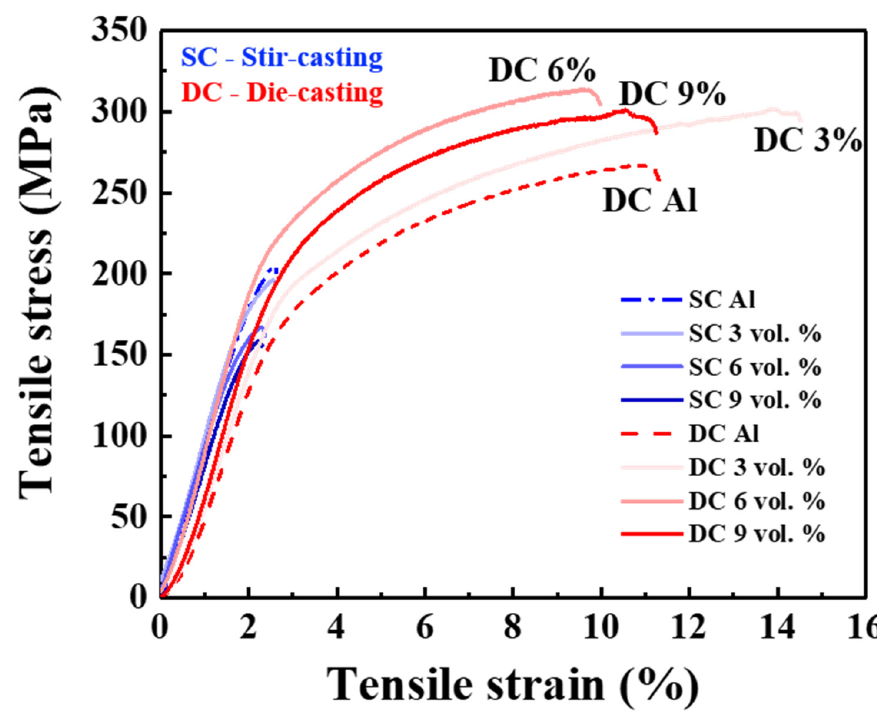
Figure 8. The stress–strain curves of the AMCs with different process.